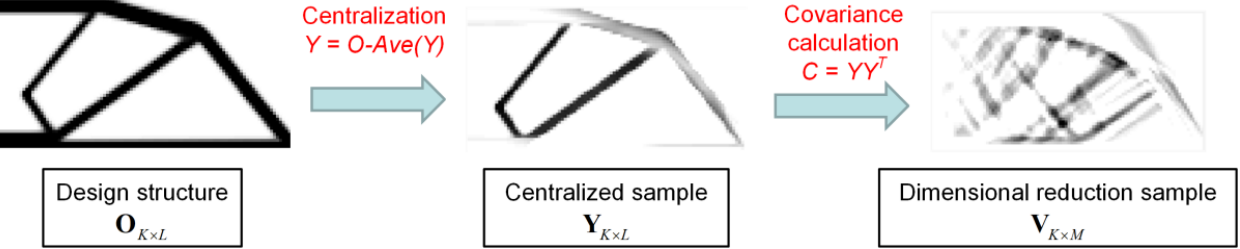
Figure 3. The process and principle of data reduction algorithm.